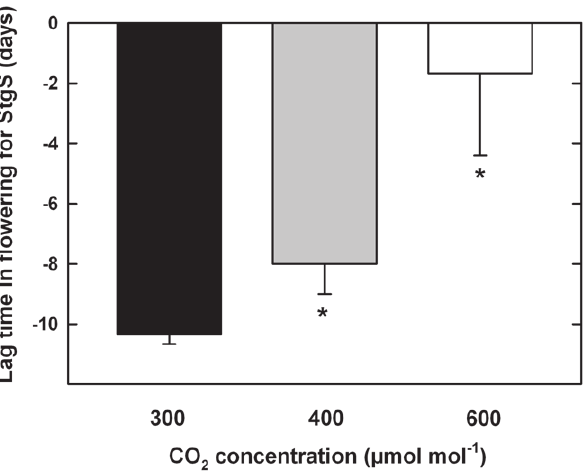
Figure 2. Lag time in days following flowering in the cultivated rice population (CL 161) that wild rice (StgS) flowered as a function of CO 2 concentration. * indicates a significant difference relative to the 300 m mol mol 2 1 baseline; Bars are 6 SE.